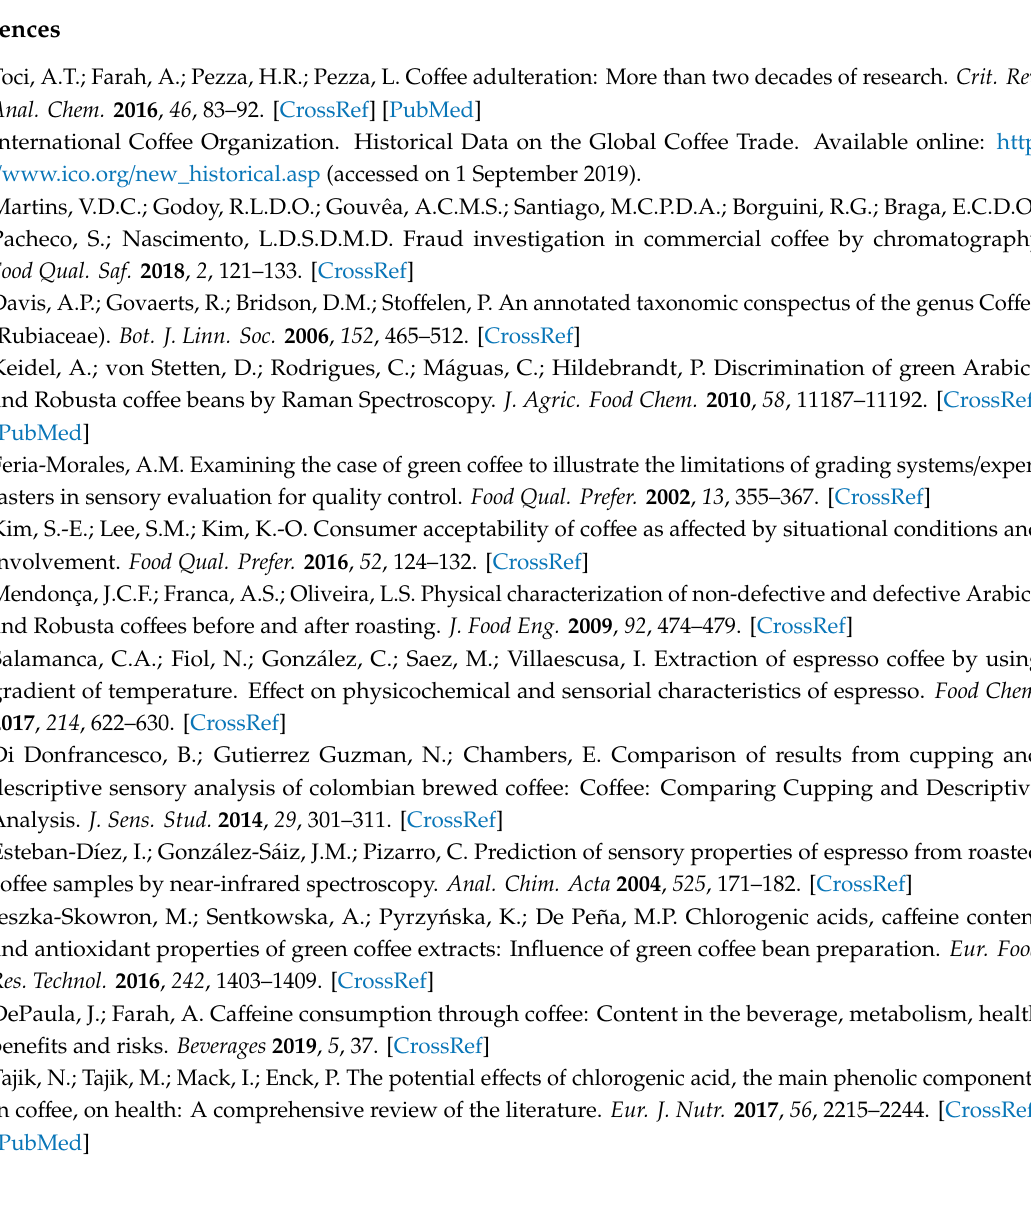
Figure S1. Map of sampling area in Java island, Indonesia. Black dots represent green bean sampling locations which were plotted using R application packages ggmap and ggsn. Figure S2: The correlation between ca ff eine content and altitude. (a) Arabica. (b) Robusta, Figure S3: The correlation between chlorogenic acid content and altitude. (a) Arabica. (b) Robusta. Table S1: Equations, Table S2: Statistical parameters of several pre-processing method on di ff use reflectance (log 1 / R) spectra by partial least squares discriminant analysis (PLS-DA), Table